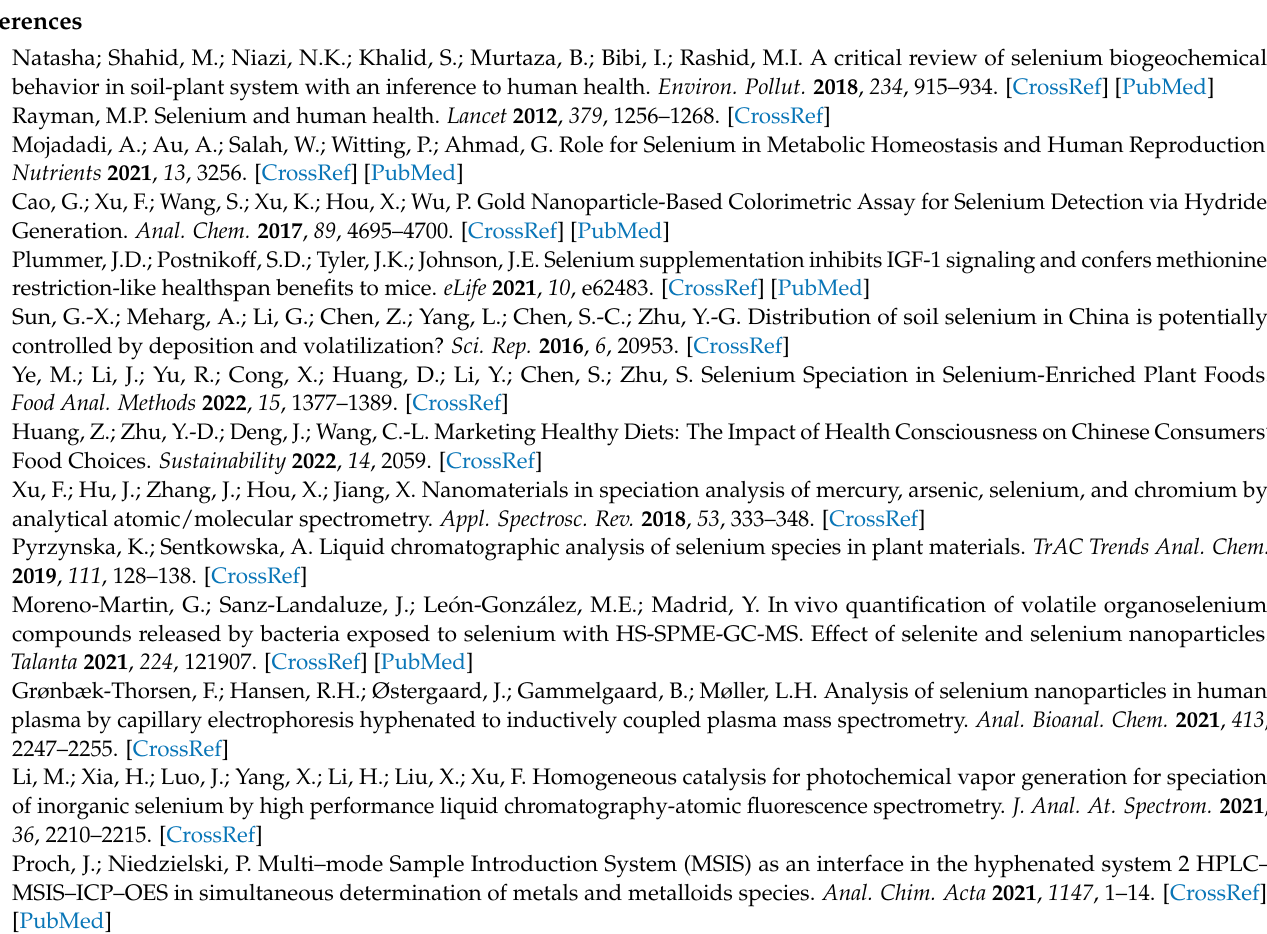
selenium species; Figure S2: Chromatograms of 13 kinds of selenium-enriched drinking water; Figure S3: Chromatograms of five selenium-enriched salts; Figure S4: Chromatograms of 12 kinds of selenium-enriched tea leaves. Table S1: Recovery test results of standard addition to selenium- enriched drinking water; Table S2: Test results of standard addition and recovery of selenium-enriched salts; Table S3: Test results of standard addition recovery of selenium-enriched tea extract; Table S4: Analysis results of selenium speciation in selenium-enriched drinking